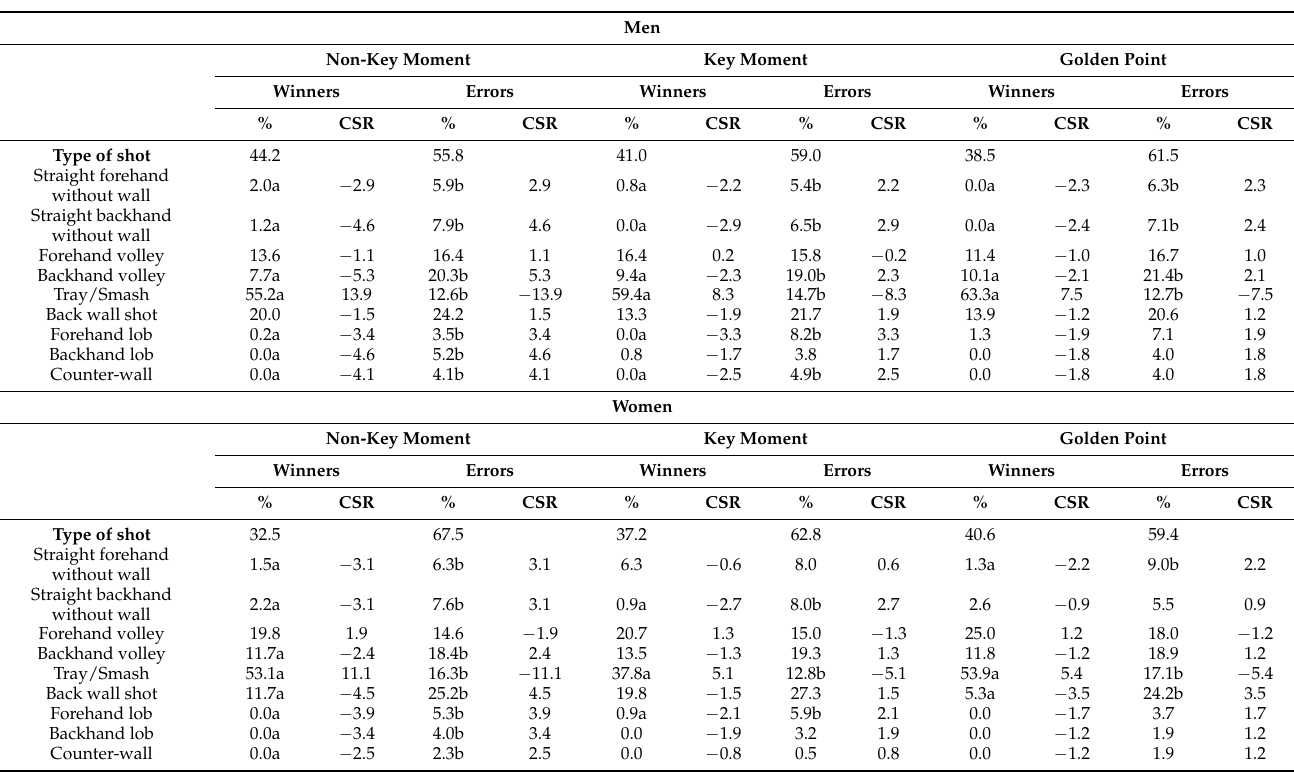
Table 1. Errors and winning strokes in men’s and women’s professional padel and their relationship with the type of stroke and the game situation according to the